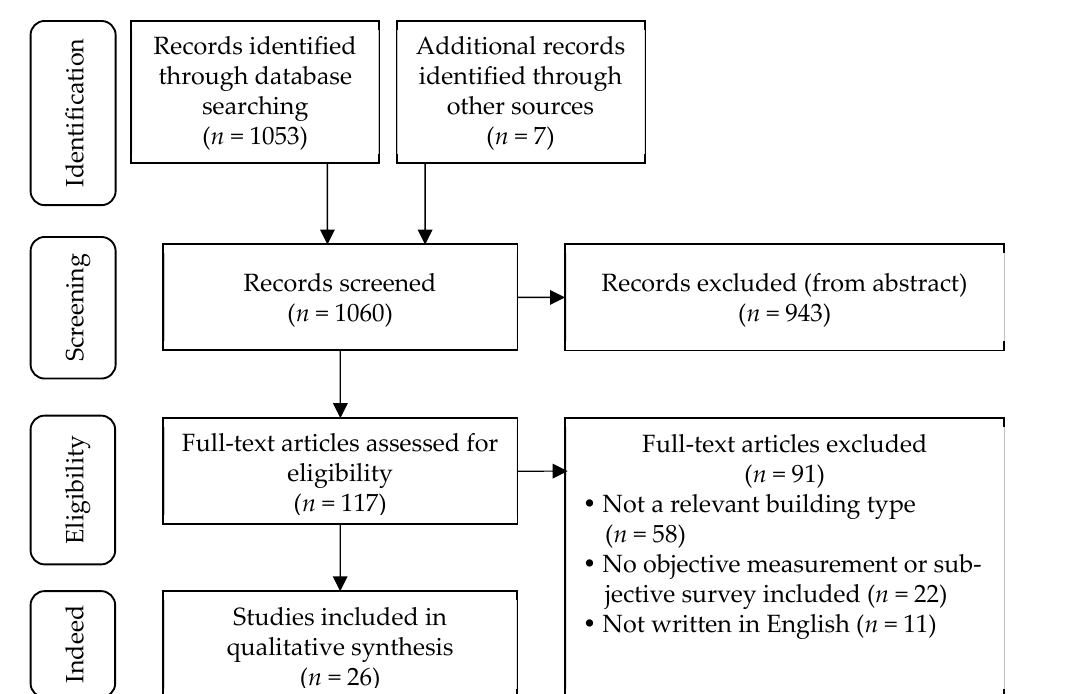
Figure 1. Flow of information through the different phases of the systematic review [24].